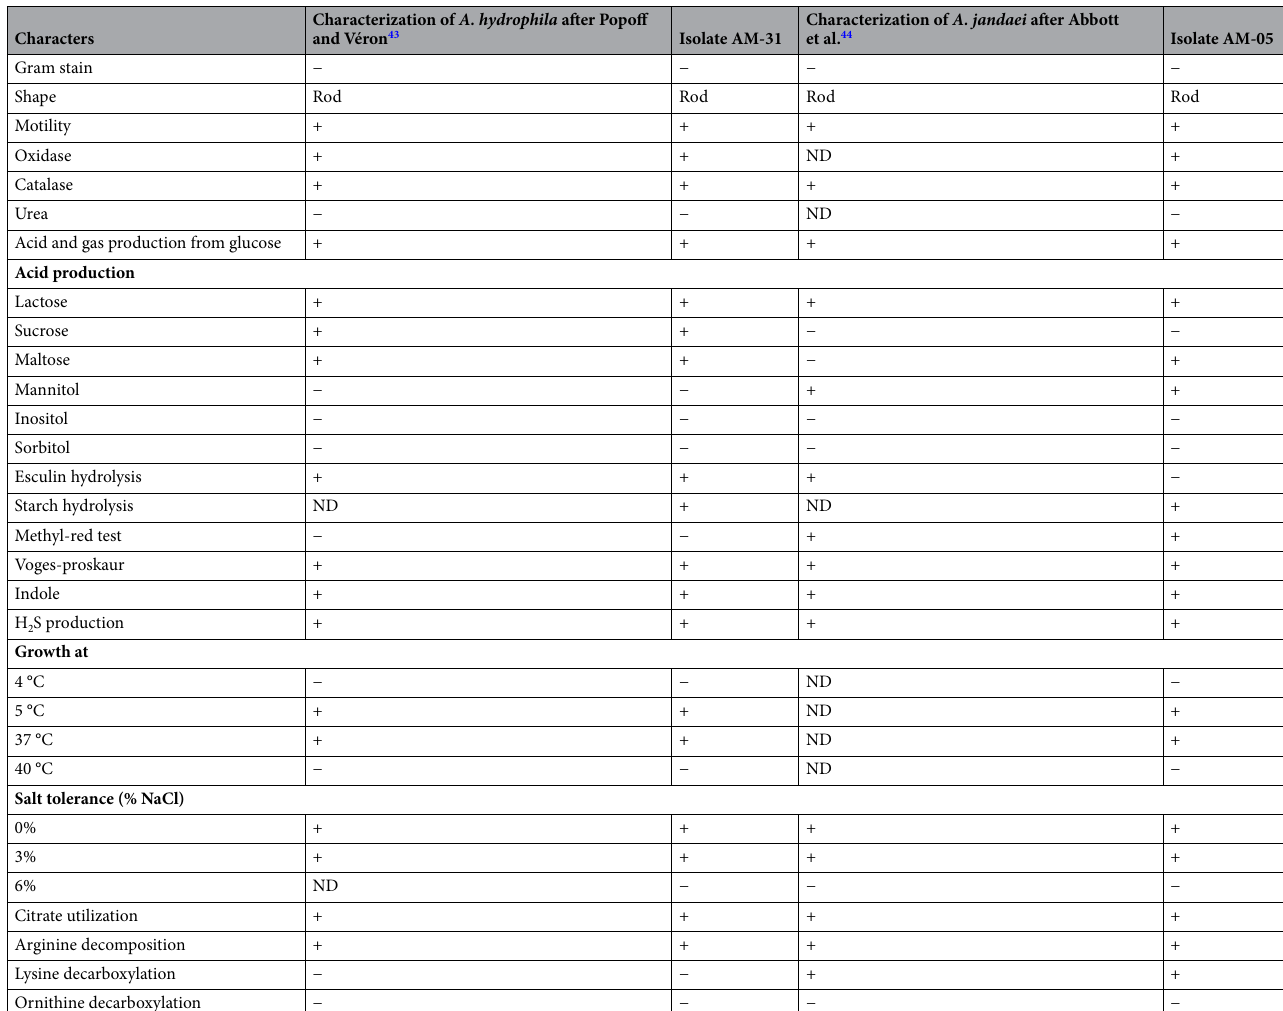
Table 1. Selected biochemical characteristics of two bacterial isolates (AM-31 and AM-05) retrieved from swabs of infected body parts and kidney of naturally-infected Anabas testudineus collected from a fish farm of Assam, India ( ND not determined, + positive, −